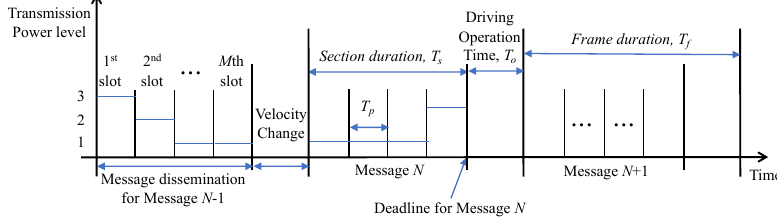
Figure 2. Timeline for the operation of